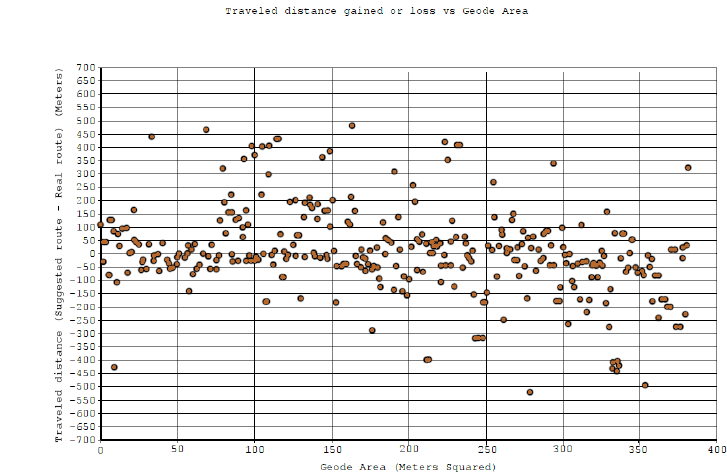
Figure 6. Scatter plot of net travel time gained or lost (Suggested route travel time minus real route travel time).